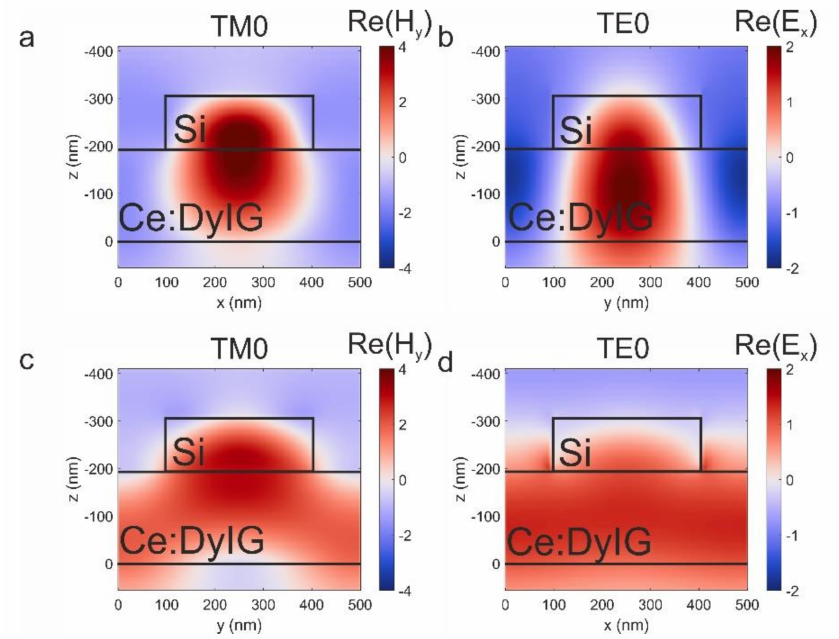
Figure 3. Electromagnetic field distribution of the TM0 ( ± 1, 0) ( a , c ) and TE0 (0, ± 1) ( b , d )